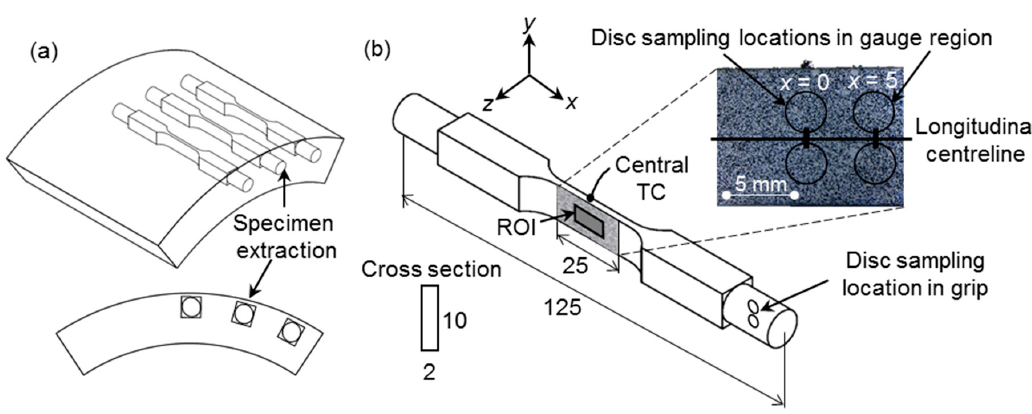
Figure 1. Illustration of the ( a ) sampling scheme in piping material and the ( b ) selected geometry for accelerated creep tests as well as the location of the disc specimens extracted for microstructural analysis of the gauge and grip regions. All dimensions are in mm. ROI = Region of Interest. TC = thermocouple. x = 0 indicates the specimen center.